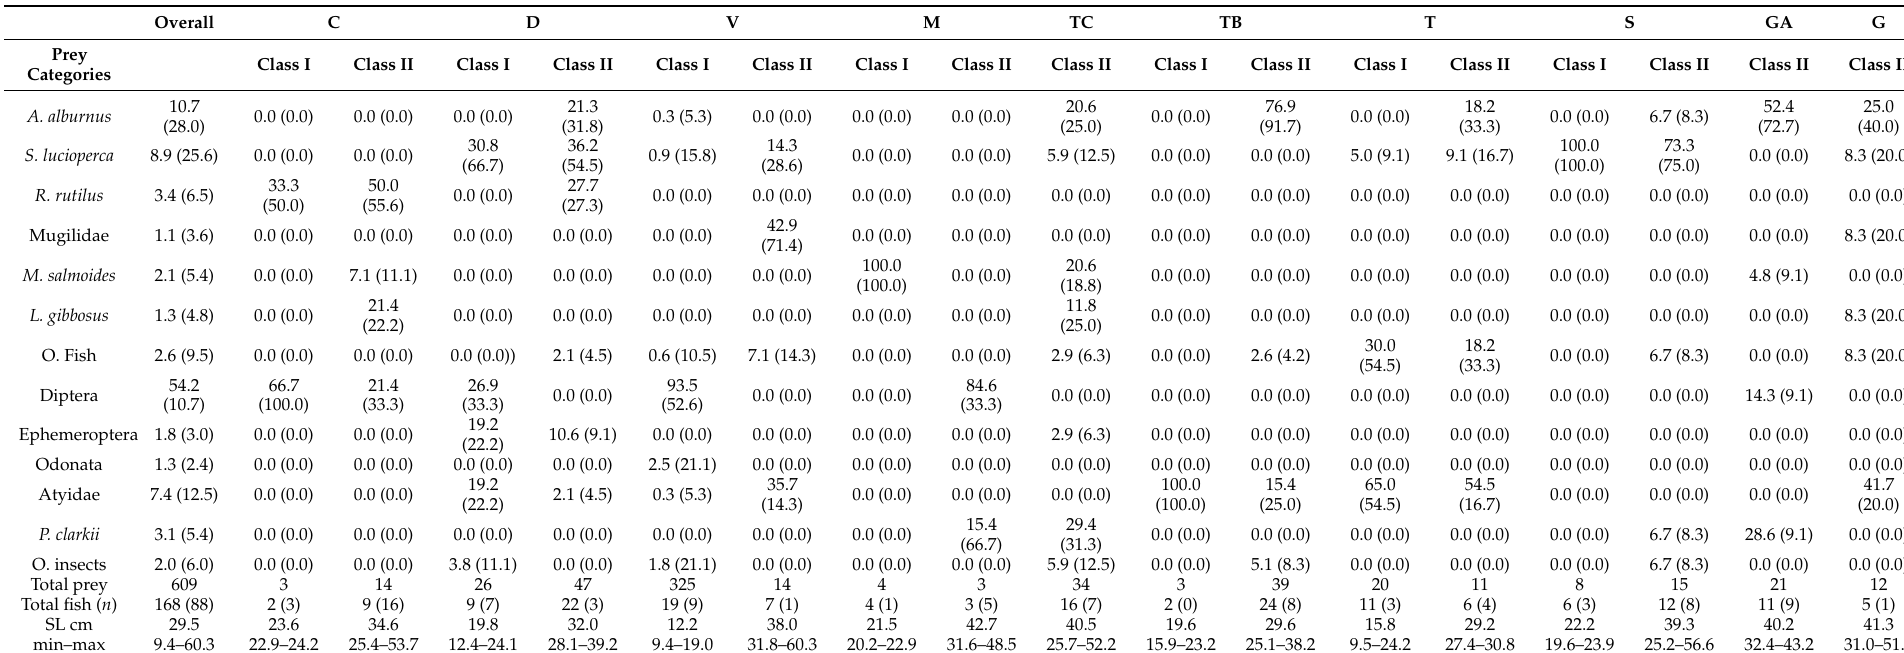
Table 1. Variation in the numeric frequency (%) and in the frequency of occurrence (% in brackets) of prey categories consumed by class I ( ≤ 25 cm SL) and class II (>25 cm SL) pikeperch Sander lucioperca populations in Portuguese basins. Total fish contains the number of pikeperch stomachs analyzed ( n ) with empty stomachs presented in brackets, per population. Mean population Standard Length (SL), with size range, minimum and maximum values (min–max) presented for each analyzed population. Sites are ordered by decreasing latitude. Population acronyms according to Figure